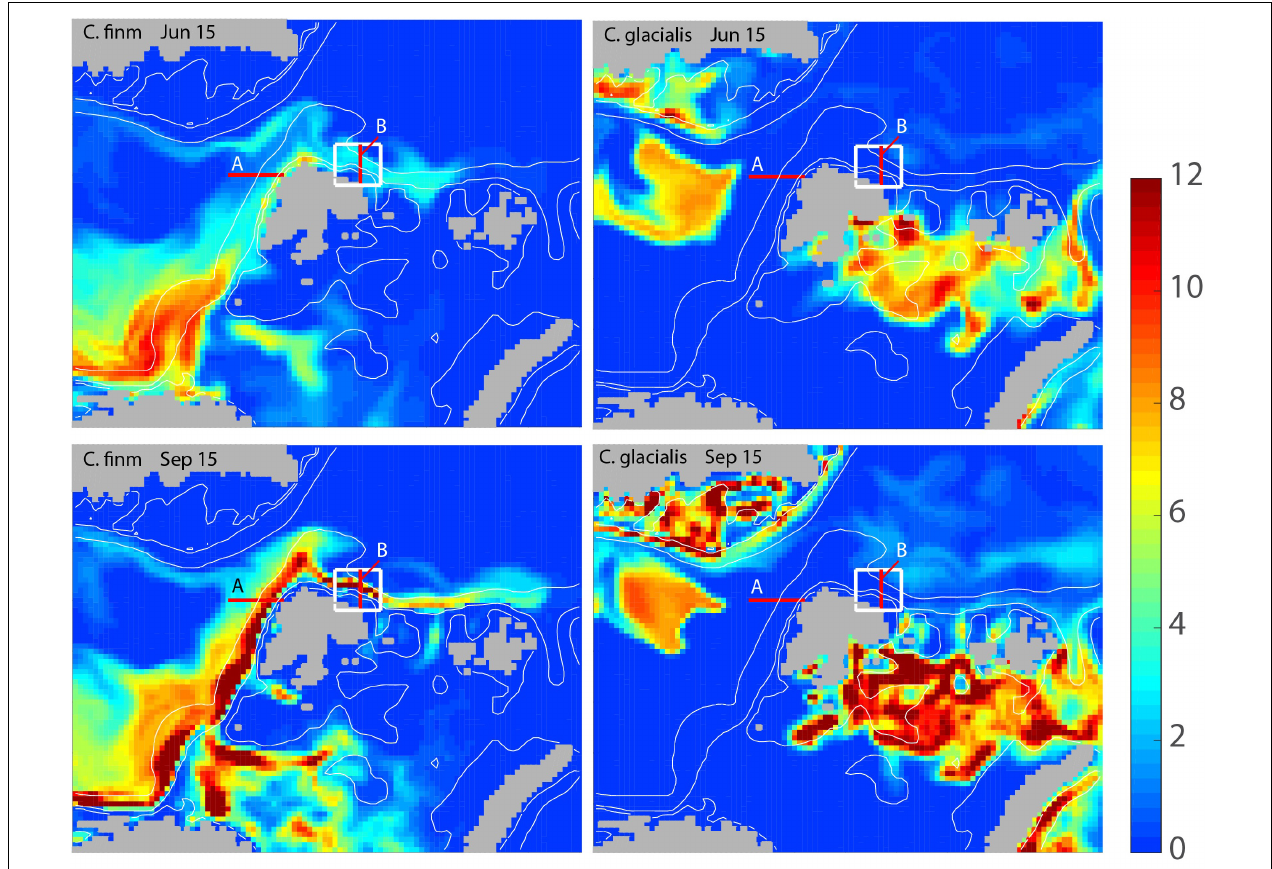
FIGURE 3 | Modeled, integrated biomass of Calanus finmarchicus (left column) and Calanus glacialis (right column) for the months June (upper panel) and September (lower panel) of 2006 around Svalbard and adjacent arctic waters (g C month − 2 ). Locations for sections A and B (red) and the box (white) north of Svalbard for which the advection of mesozooplankton is calculated are also shown.